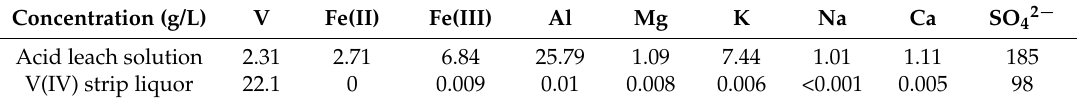
Figure 4. Proposed flowchart for preparation of the V(IV) strip liquor from vanadium-bearing shale. Table 2. Chemical composition of the acid leach solution and the V(IV) strip liquor.